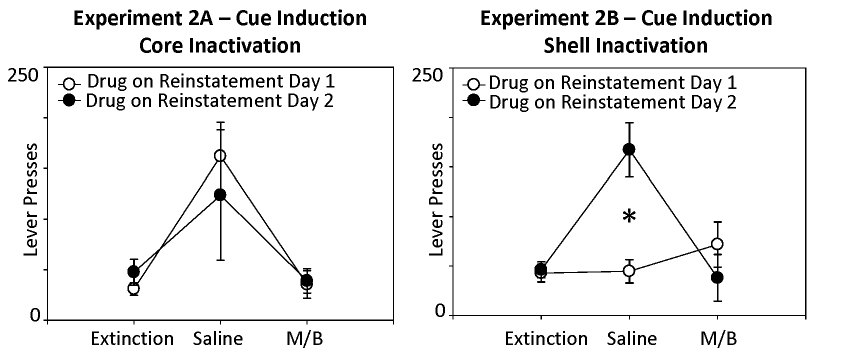
Figure 4. Although NAcc core and shell inactivation caused a main effect of drug on cue-induced reinstatement (Fig. 3), there was also a significant three-way interaction. As shown here, the rats who received muscimol/baclofen injections in the NAcc shell on the first reinstatement day did not reinstate food-seeking behavior on the second test when they received saline injections. The star represents a significant difference in responding between animals that received saline injections on the first or second test day. In contrast, rats with NAcc core inhibition showed attenuated reinstatement regardless of which day the drug was given.